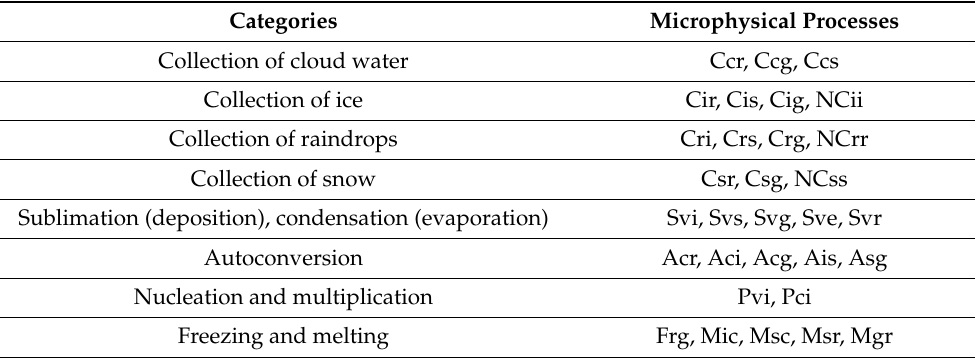
Table 2. For the 31 microphysical processes, the underlined letters are the abbreviations for the name of the